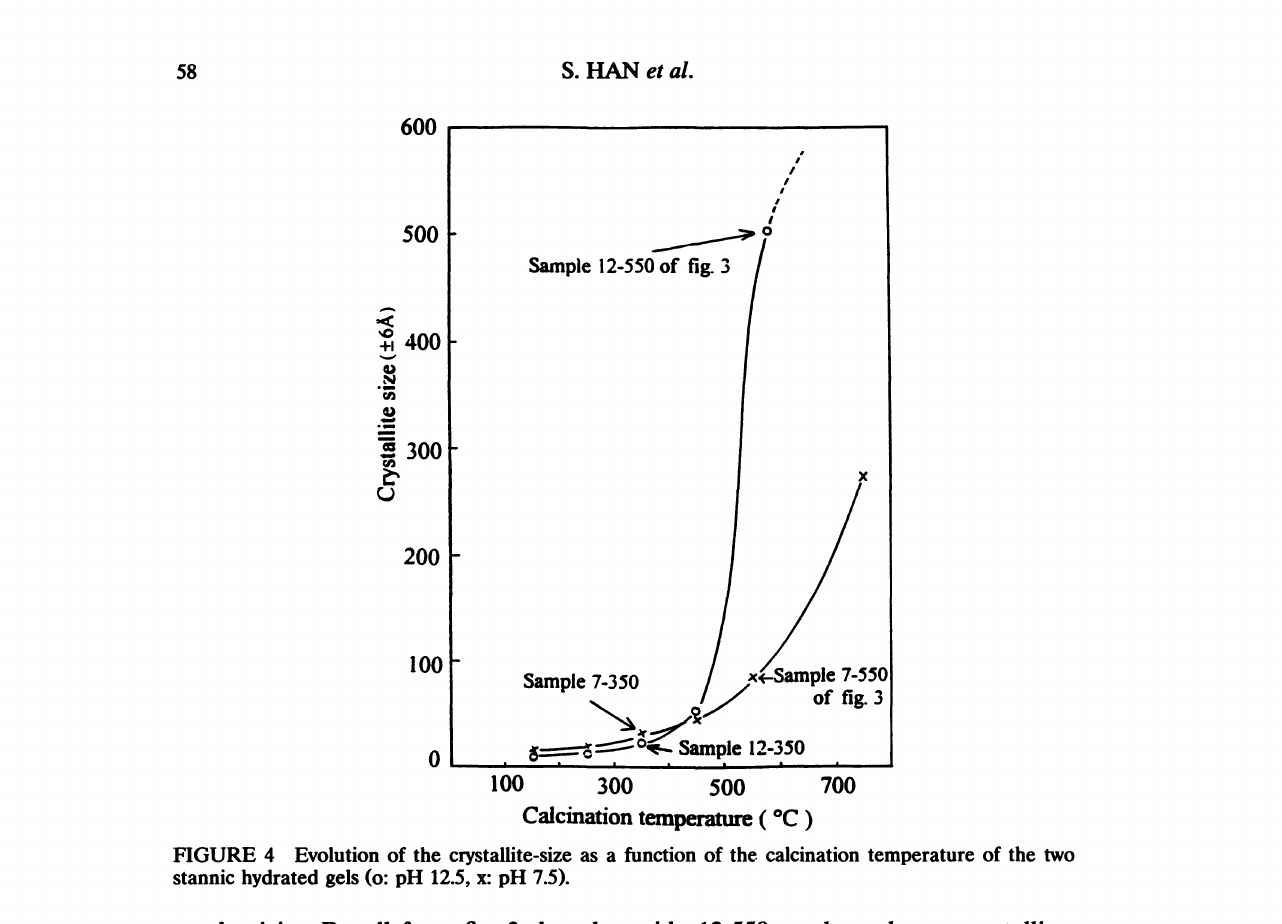
FIGURE 4 Evolution of the crystallite-size as a function of the calcination temperature of the two stannic hydrated gels (o: pH 12.5, x: pH